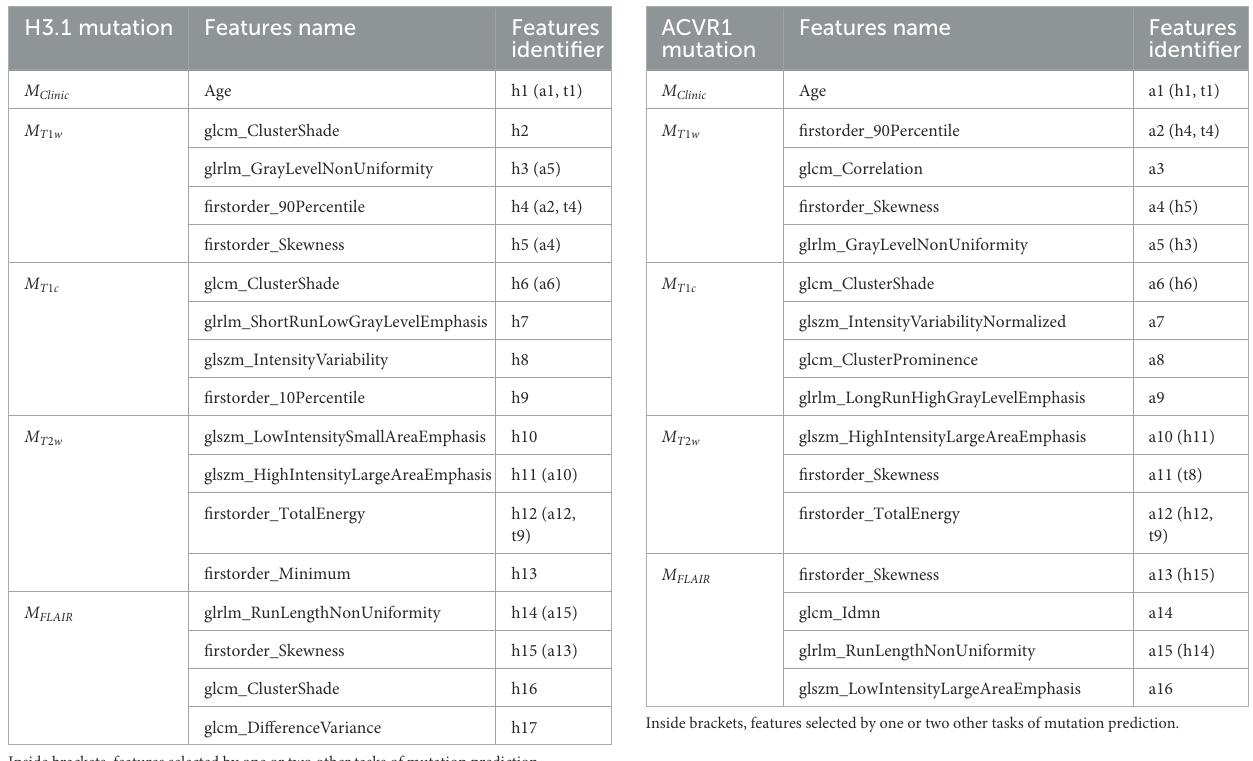
TABLE 4 Subsets of features selected by the five different models M Clinic , M T 1 w , M T 1 c , M T 2 w , and M FLAIR to predict ACVR1 mutation.